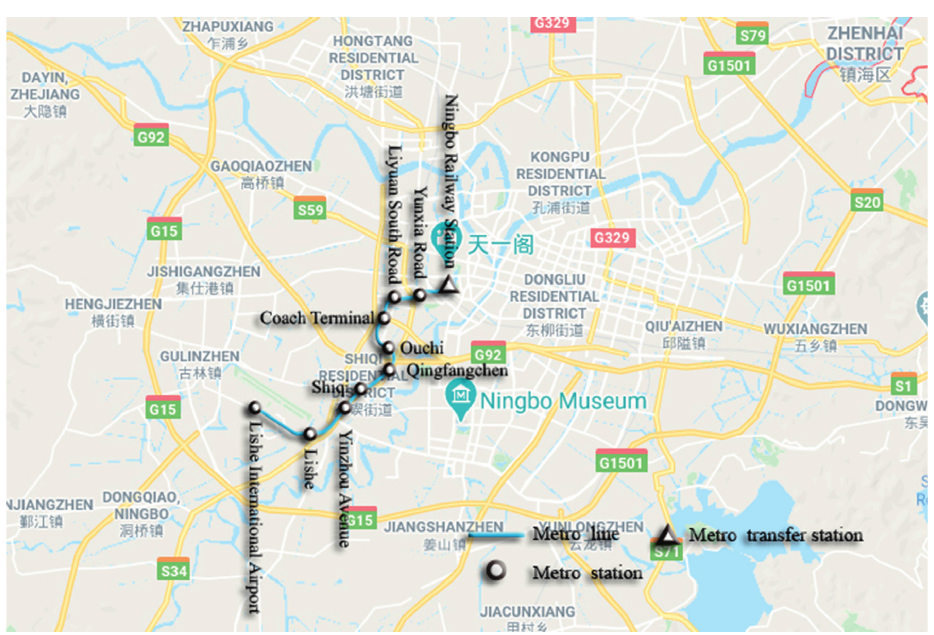
Figure 7: Ningbo rail transit route map. Table 2: Information about the metro